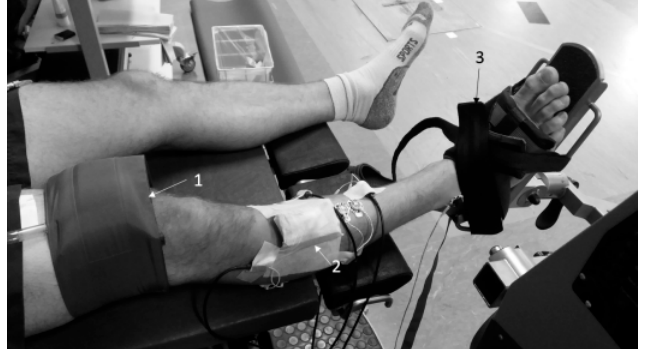
Figure 1. Experimental Setup. (1) Pressure cuff. (2) CW near-infrared spectroscopy device + adhesive tape. (3) Footrest including safety belts.